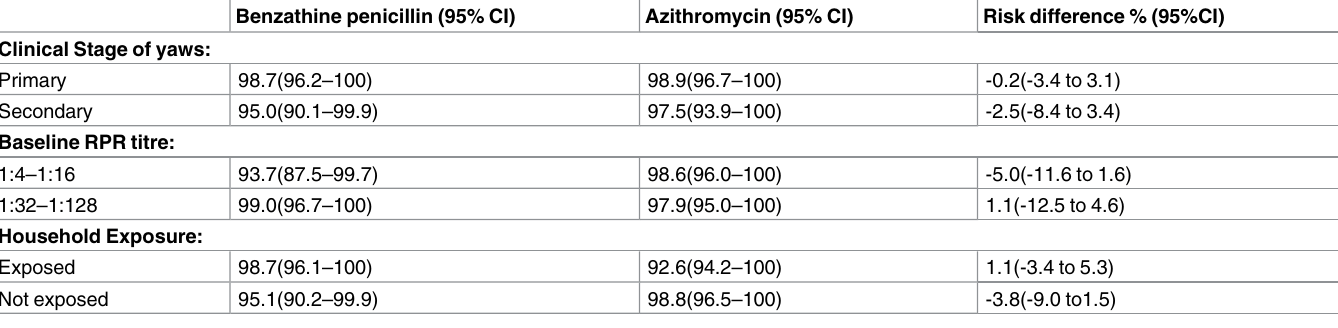
Three (1.8%) participants in the azithromycin group and 4 (2.5%) in the penicillin group with ulcerative yaws lesions did not resolve 3 weeks after treatment and were classified clini- cally as “treatment failures”. All participants considered as “treatment failures” were re-treated with intramuscular penicillin and all ulcers subsequently resolved within 2 weeks. Five subjects with ulcerative lesions which had healed at 3 weeks and had achieved serological cure were found to have recurred during the 3 month follow up period. Of these 3 (1.7%) occurred in the azithromycin group and 2 (1.3%) in the penicillin group. However due to the fact that subjects had achieved serological cure, lesions were likely of a different aetiology. Azithromycin treatment also proved to be non-inferior to penicillin therapy in subgroup analyses of primary outcome (clinical cure at 3 weeks) by clinical stage of yaws, baseline RPR titre and household exposure (Table 3). Table 3. Sub Group Analysis of Primary Outcome (Clinical Cure at 3